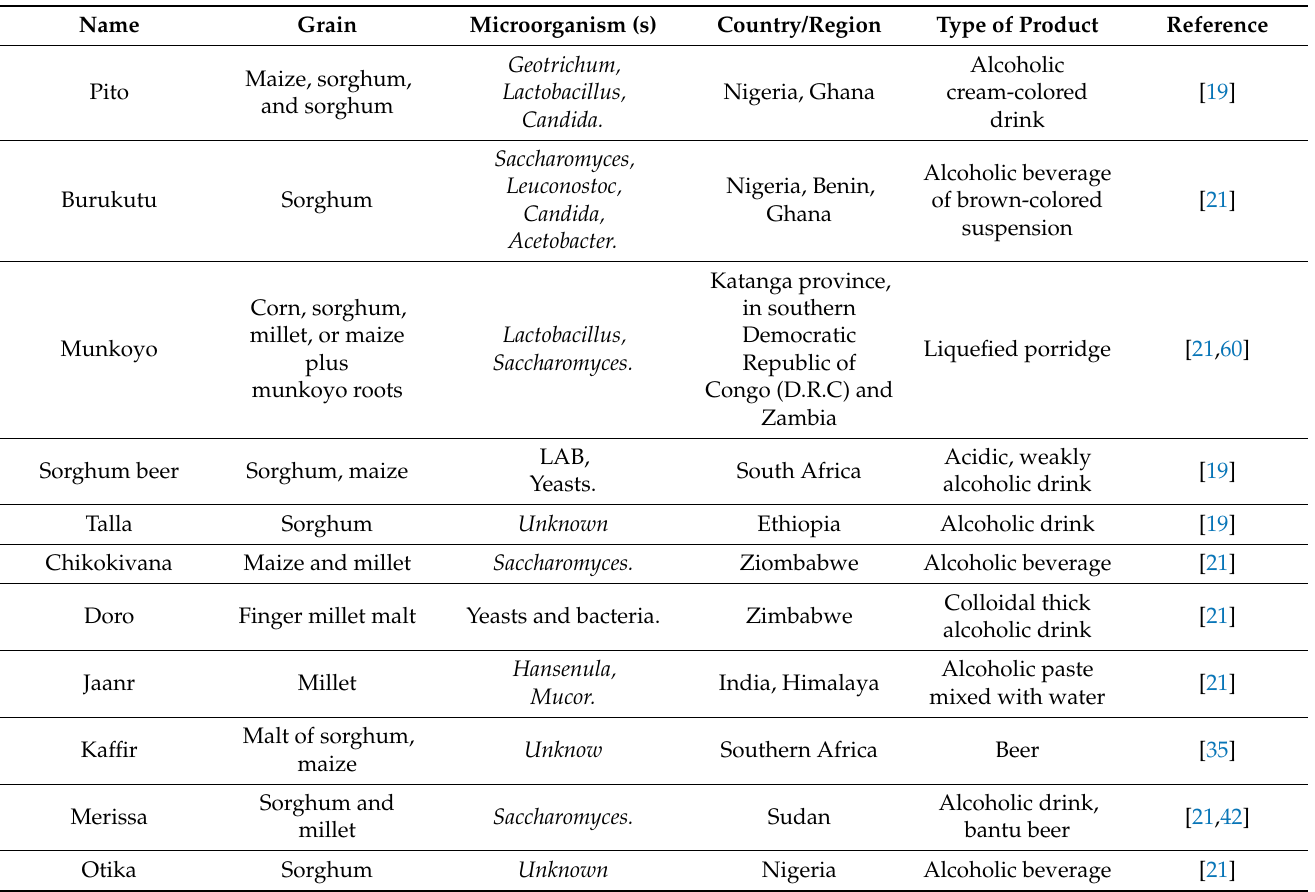
Table 3. Examples of sweet/sour alcoholic fermented MG porridge used in different regions of the